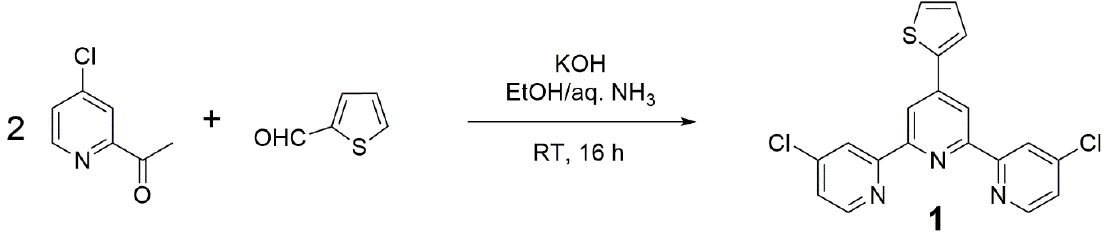
Figure 2. Preparation of terpyridine (Compound 1 ).